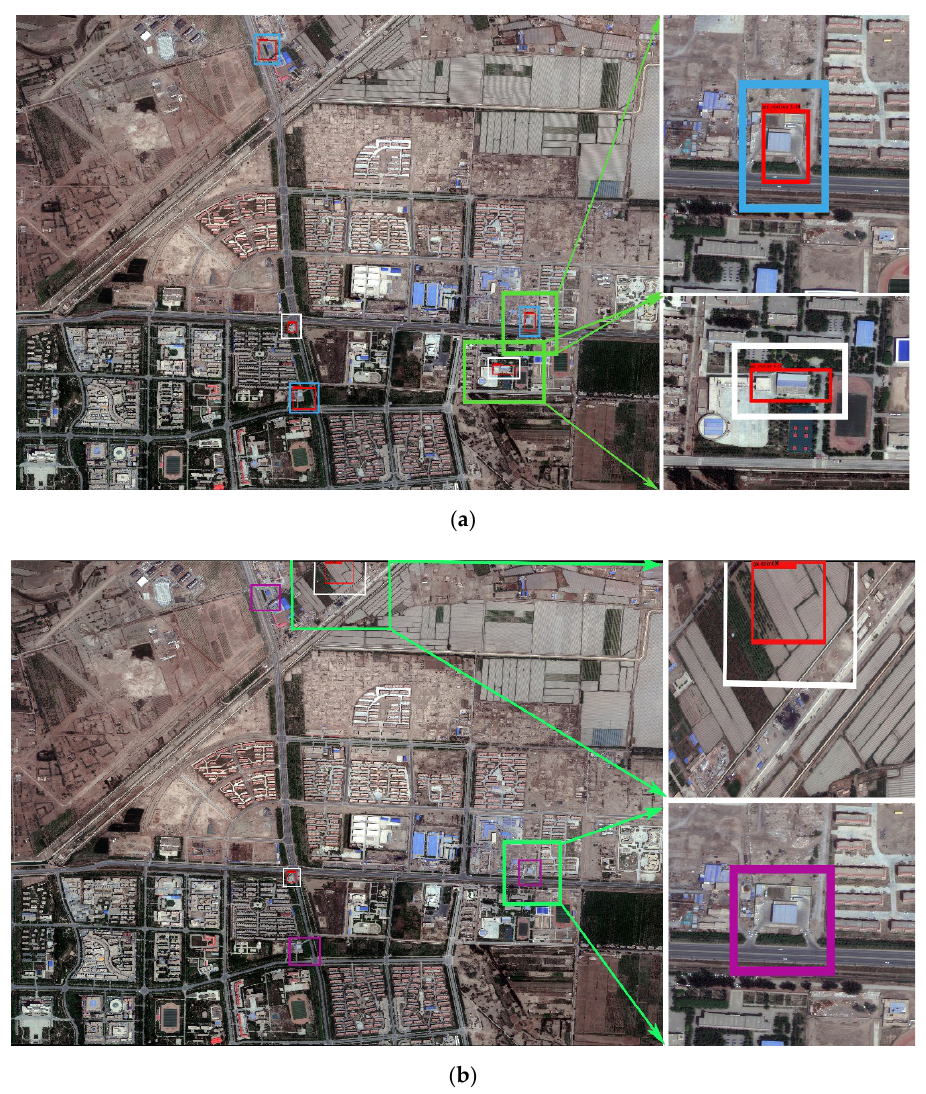
Figure 12. Detection results of gas stations in remote sensing images by YOLO-S-CIOU and YOLOv3. ( a ) is the detection result of YOLO-S-CIOU on WorldView data and ( b ) is the detection result of YOLOv3 on WorldView data. A red box in ( a ) and ( b ) is a detection result box by networks; a blue box in ( a ), ( b ) refers to true positive (TP); a purple box refers to false negative (FN); a white box refers to false positive (FP), and a green box in ( a ) and ( b ) indicates the area of the enlarged